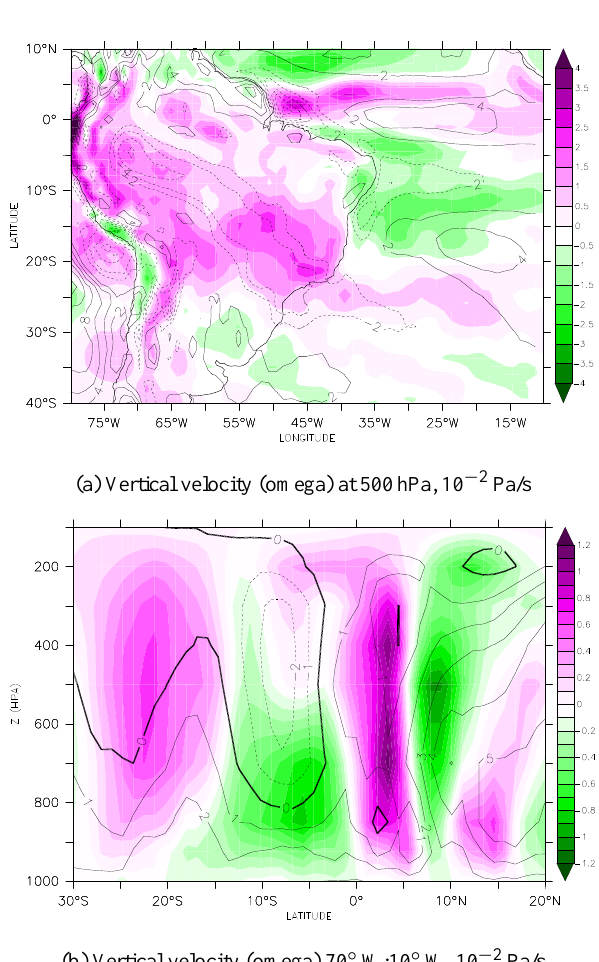
Fig. 14. MH - PI JFM difference in (a) vertical velocity at 500hPa in hPa/s, and (b) vertical velocities averaged over 70 ◦ W:10 ◦ W. Negative Fig. 14. MH-PI JFM difference in (a) vertical velocity at values indicate upward motion. Contours are PI JFM values. 500hPa in 10 − 2 Pas − 1 , and (b) vertical velocities averaged over 70 ◦ W:10 ◦ W. Negative values indicate upward motion. Contours are PI JFM